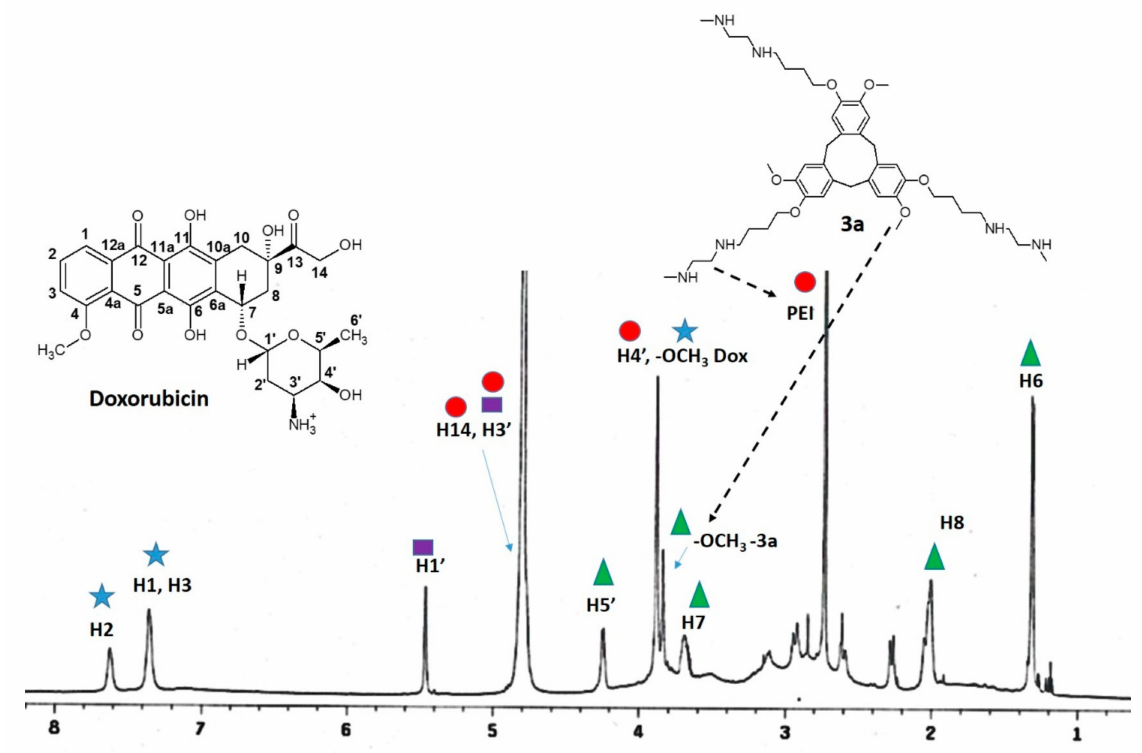
Figure 6. The groups marked with the same symbol are spatially close to each other according to NOE and NOESY NMR